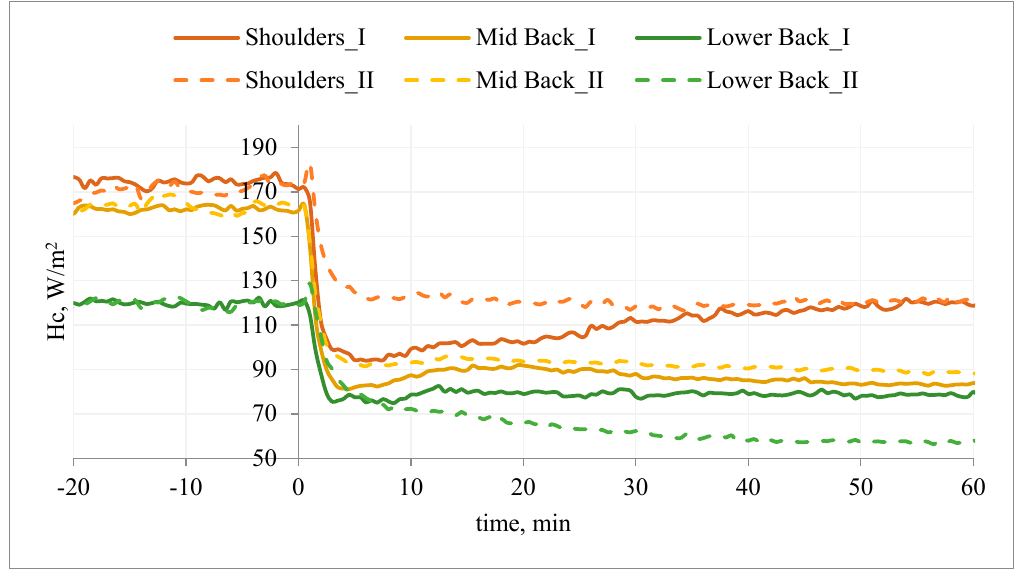
Figure 8. An example of the heat flux density, Hc, on selected manikin segments (back) during testing of type A undergarments without PCM (variant I) and with PCM (variant II).